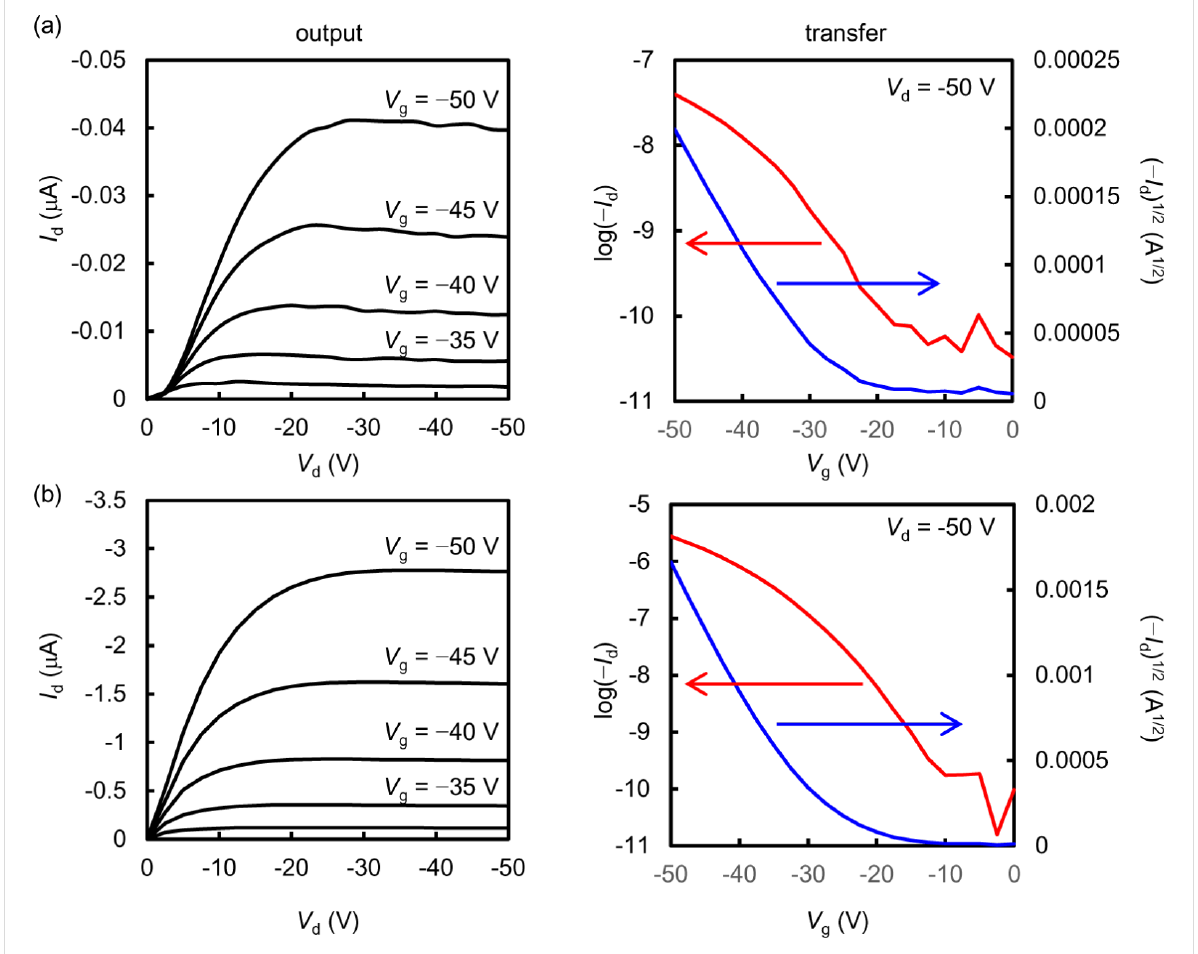
Figure 5: Output and transfer characteristics of the representative OFETs with a thin film of (a) syn -DBBDF 5 ( T sub = 30 °C) and (b) syn -DNBDF 6 ( T sub = 90 °C) on HMDS-treated Si/SiO 2 substrates.